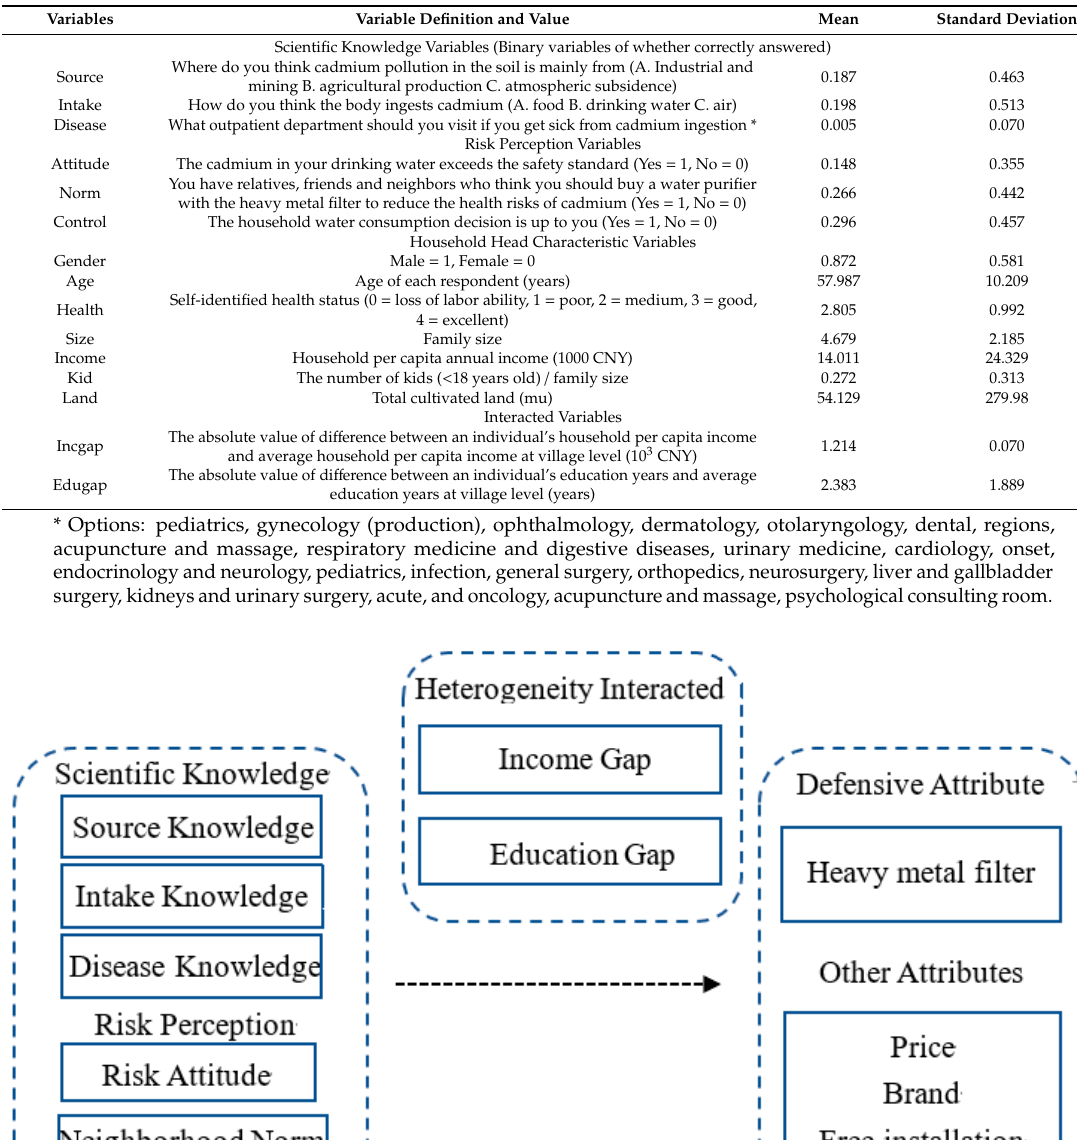
Table 3. The definition of variables and summary statistics.